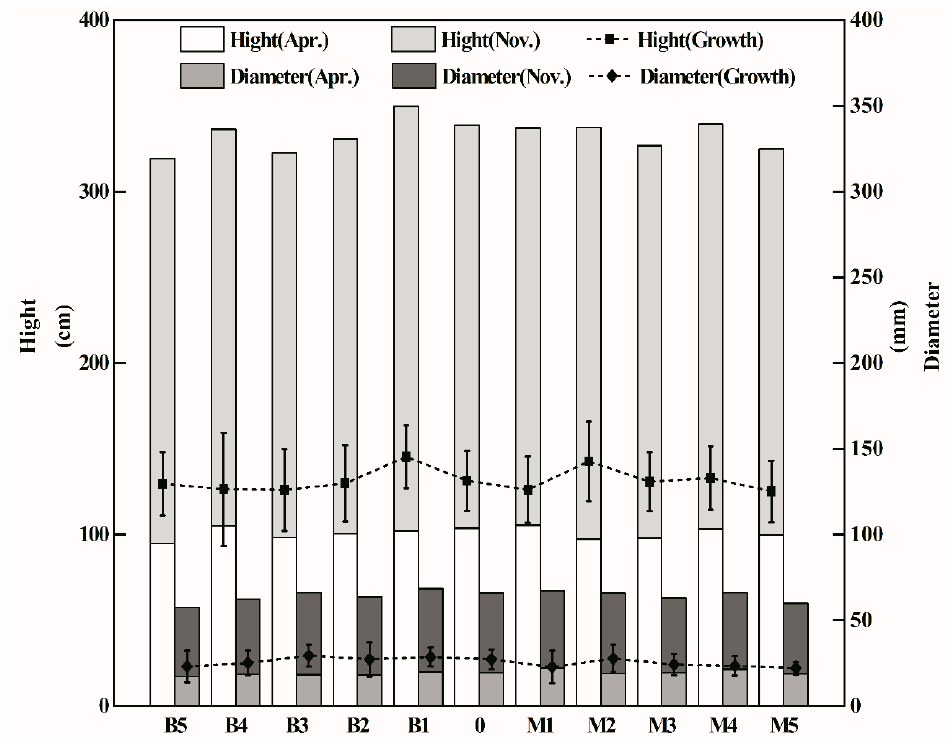
Figure 1. Growth of Chinese fir in a growing season. B and M indicate bamboo biochar and bacteria-inoculated biochar; 0, 1, 2, 3, 4, and 5 indicate control, 2.22 t · ha − 1 , 4.44 t · ha − 1 , 6.67 t · ha − 1 , 8.89 t · ha − 1 , and 11.11 t · ha − 1 .